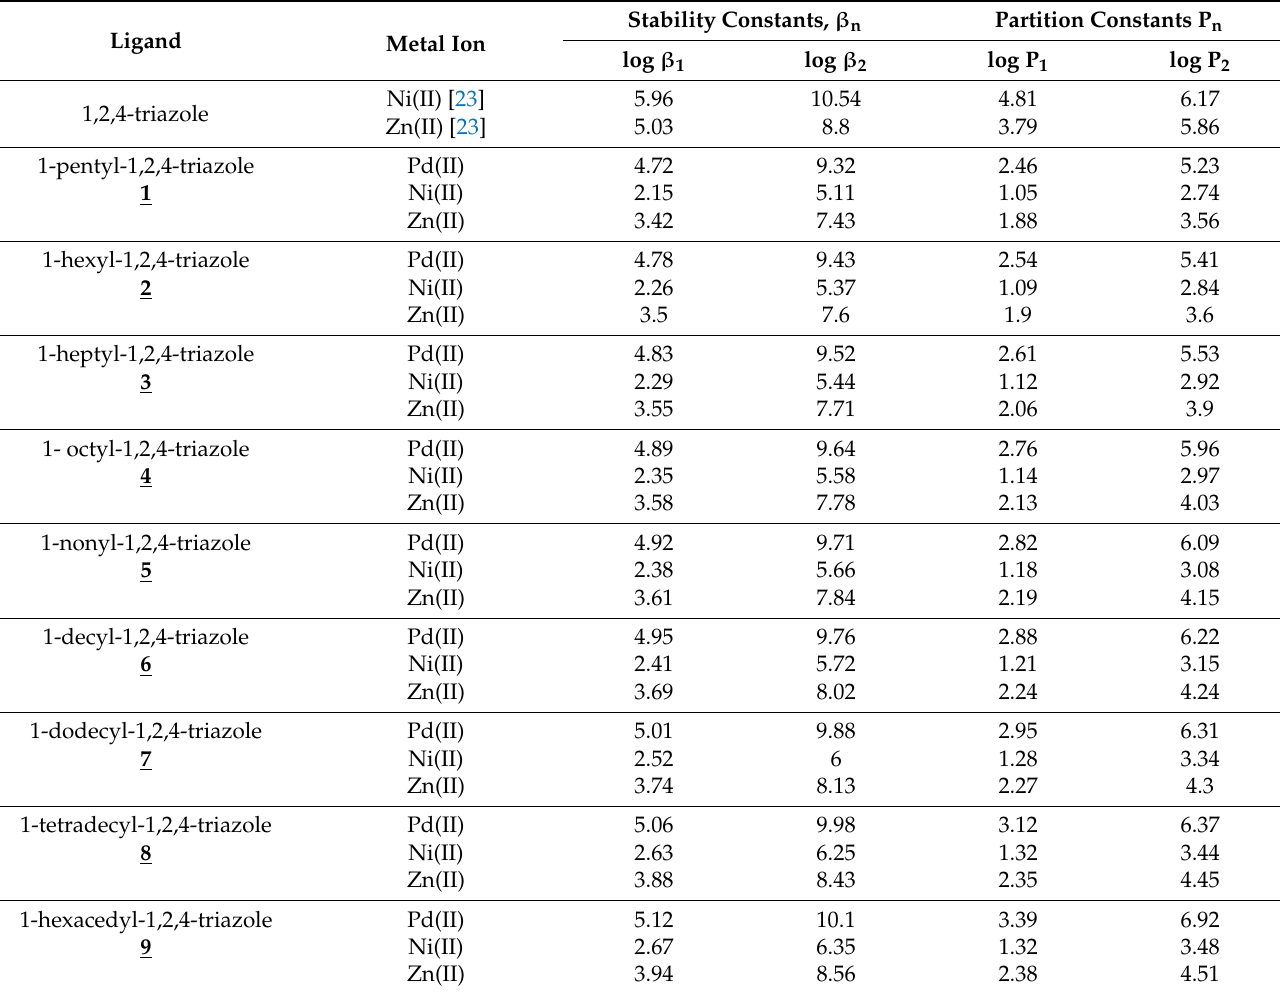
Table 4. Comparison of the stability constants ( β n ) and partition constants (P n ) of M(II) complexes with 1,2,4-triazole and 1-alkyl-1,2,4-triazole and at 20 ◦